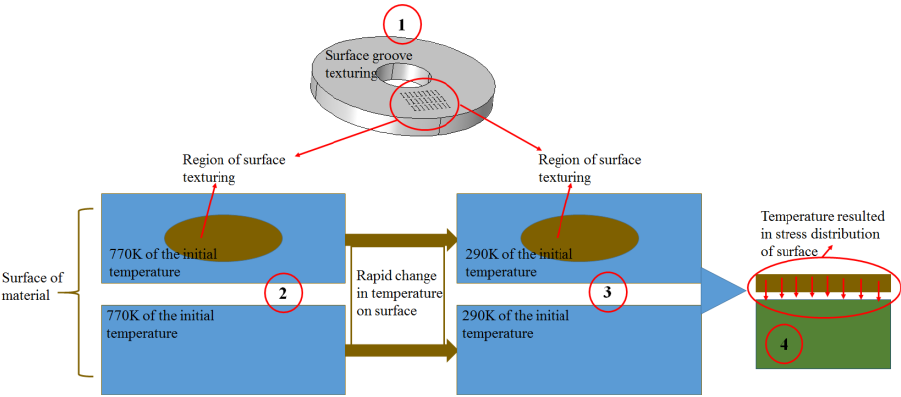
Figure 1. Detail flow chart of thermal stress generation.